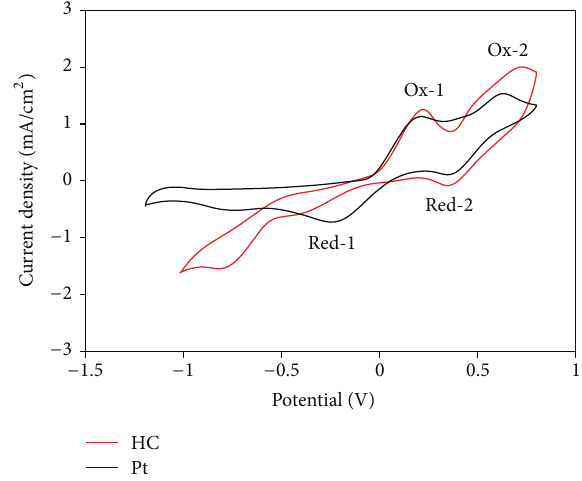
Figure 4: Cyclic voltagramms of Pt and HC film obtained at a scan rate of 50mV/s